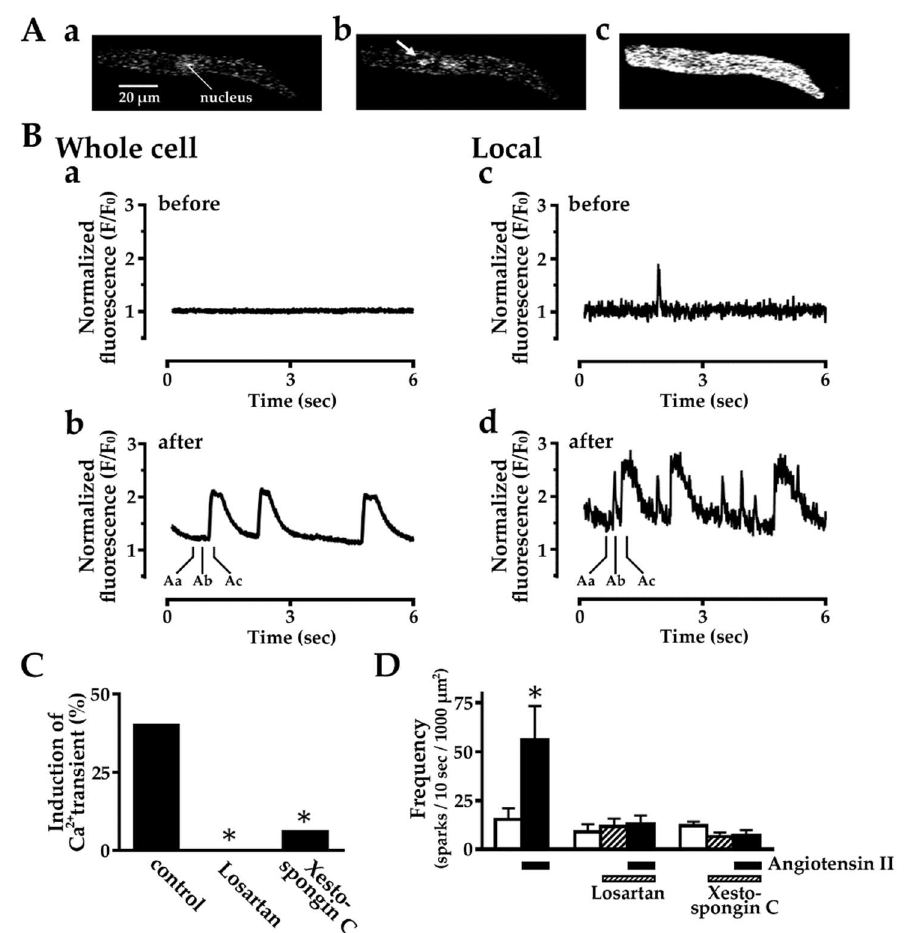
Figure 3. Effect of angiotensin II on intracellular Ca 2+ dynamics in pulmonary vein cardiomyocytes loaded with the Ca 2+ sensitive fluoroprobe fluo-4. ( A ) Typical fluorescence images under quiescence (a), on firing of Ca 2+ sparks (b; arrow) and on firing of a Ca 2+ transient (c); ( B ) Time courses of the fluorescence of the entire cell (a, b) and in the circular region of 1 µ m in diameter at the site shown by the arrow in Ab (c, d) before (a, c) and after the application of 1 µ M angiotensin II (b, d). The time points Aa, Ab and Ac in panel b and d corresponds to the panels a, b and c of A; ( C ) Summarized results for the rate of induction of Ca 2+ transients by angiotensin II. Columns indicate the rate of induction from 14 to 17 experiments. Asterisks indicate statistical significance ( p < 0.05) from the control as evaluated by the Fisher’s exact test; ( D ) Summarized results for the increase in the frequency of Ca 2+ spark firing by angiotensin II. Open columns, hatched columns and closed columns indicate the frequency in the absence of agents, after the application of 10 µ M losartan or 3 µ M xestospongin C, and after further application of 1 µ M angiotensin II, respectively. Columns and vertical bars indicate the mean ± S.E.M. from 6 experiments. Asterisks indicate statistical significance ( p < 0.05) from the value in the absence of agents as evaluated by the Dunnett’s test for multiple comparisons.